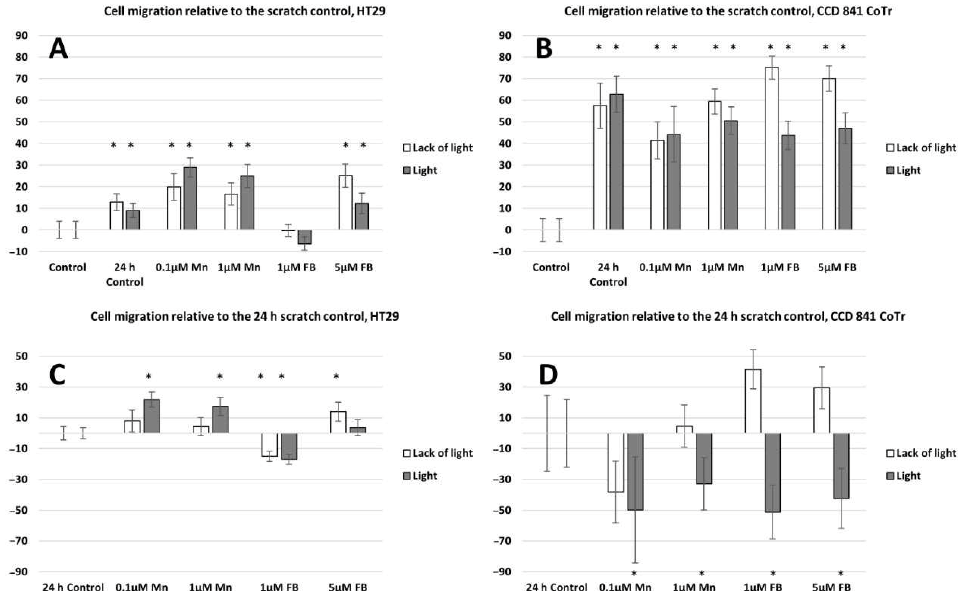
Figure 6. Percent of cell migration relative to the scratch control: ( A )—HT29 and ( B )—CCD 841 CoTr; cell migration relative to the 24 h scratch control: ( C )—HT29 and ( D )—841 CoTr. A negative percent means inhibiting the migration. Columns and bars show the mean ± standard deviation (n = 3). Statistical significance was analyzed at p < 0.05. * Statistical significance in comparison to appropriate control at p < 0.05.